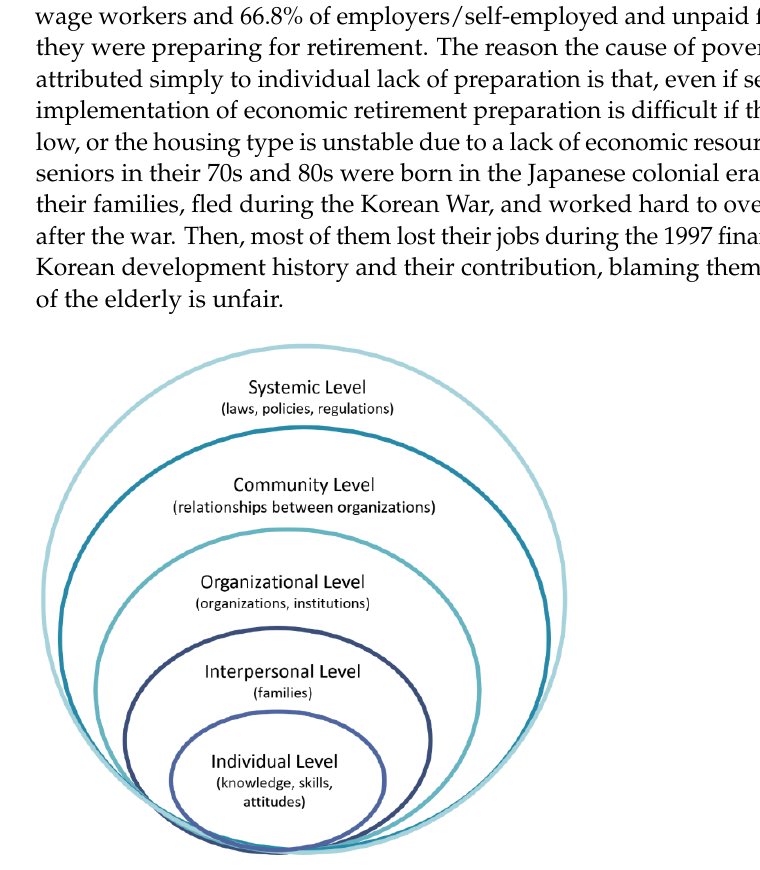
Figure 7. Socioecological model. Source: Concept from McLeroy et al. [29].